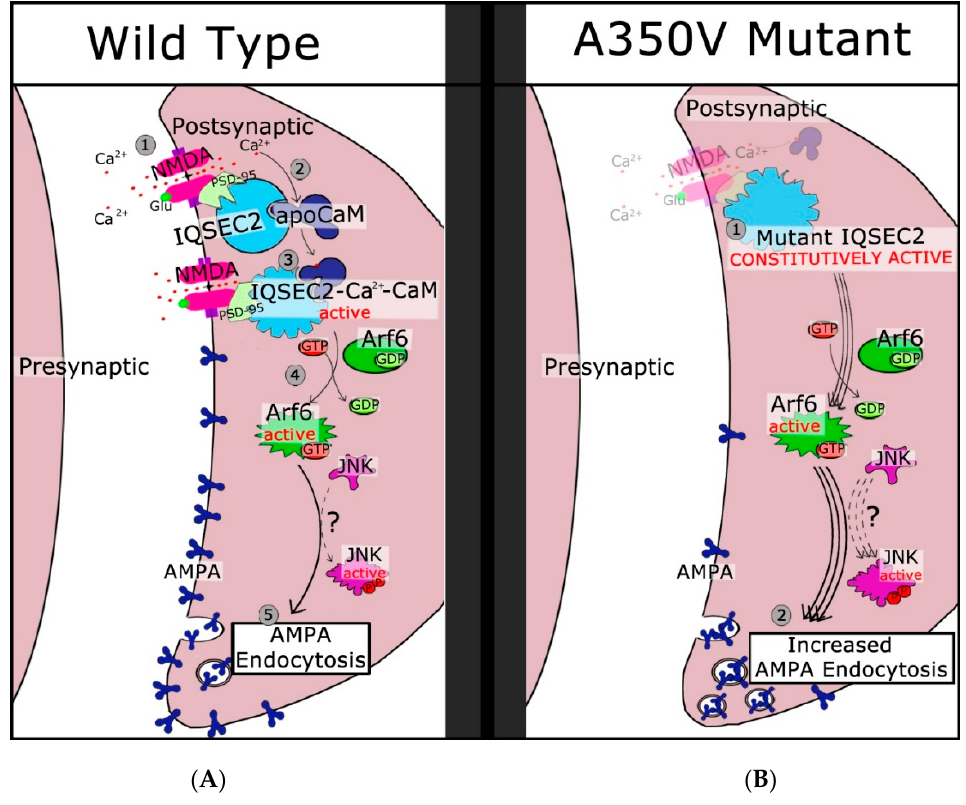
Figure 2. Signal transduction pathway in wild type and A350V mutant IQSEC2. In the left panel ( A ), binding of glutamine to the NMDA receptor (pink shape) allows calcium ion influx (step 1). Binding of calcium to calmodulin present on IQSEC2 (light blue shape) causes a conformational change (step 2) in IQSEC2 resulting in activation of the SEC7 catalytic domain (step 3). GDP is exchanged for GTP on ARF6 (green shape), resulting in active ARF6 (step 4). Additional steps including JNK activation (purple shape) lead to endocytosis of AMPA receptors (step 5). In the right panel ( B ), the A350V mutant IQSEC2 is constitutively active (step 1) leading to constant activation of ARF6 and JNK, enhanced endocytosis of AMPA receptors (step 2), and decreased surface AMPA expression. (Reproduced from reference 17.)